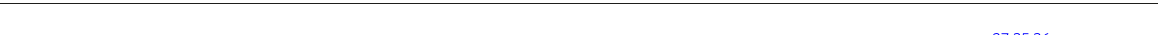
Fig. 3 Paleo-proxy records of ice sheet, Atlantic circulation and climate changes from 21 to 10 ka. a North Atlantic ice-rafted debris 27,35,36 records and a proxy (terrestrial organic matter isoprenoid tetraether (BIT) index) record of Eurasian fl uvial discharge 32 , b West and high-latitude North Atlantic 231 Pa/ 230 Th records that contain data over the Holocene, deglacial and LGM (see also Fig. 2a), c northern tropical Atlantic (5 – 15 o N) coral proxy records of ocean radiocarbon (B-Atm 14 C ages with ellipsoid error bars) 3 , d sortable silt mean grain size record of Iceland-Scotland Over fl ow Water strength (an important component of NADW) 6 , e atmospheric CO 2 record from the West Antarctic Ice Sheet Divide ice core (WDC) 51 and atmospheric Δ 14 C record from the IntCal13 compilation 50 , and f Northern Greenland ice core temperature proxy ( δ 18 O) record 55 . Triangle and diamond symbols respectively signify 14 C and non- 14 C chronological tie-points. Numbers and letters in brackets denote the identity of the sediment cores marked in Fig. 1, with references listed in Table 1. Bold characters in the fi gure legend and the square symbols indicate new 231 Pa/ 230 Th reconstructions from this study. Yellow shading — early HS1, blue shading — late HS1, green shading — YD, grey shading mark the HS1 – BA transition and the YD-early Holocene